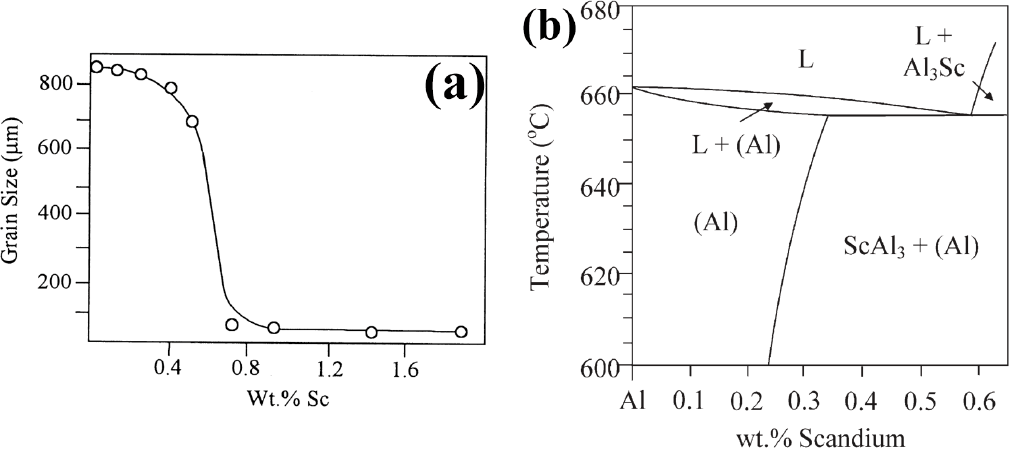
Figure 2. Curve of grain size addition of Sc ( a ) and phase diagram of Al-Sc ( b ). Reprinted with permission from [57], 1998, Elsevier.